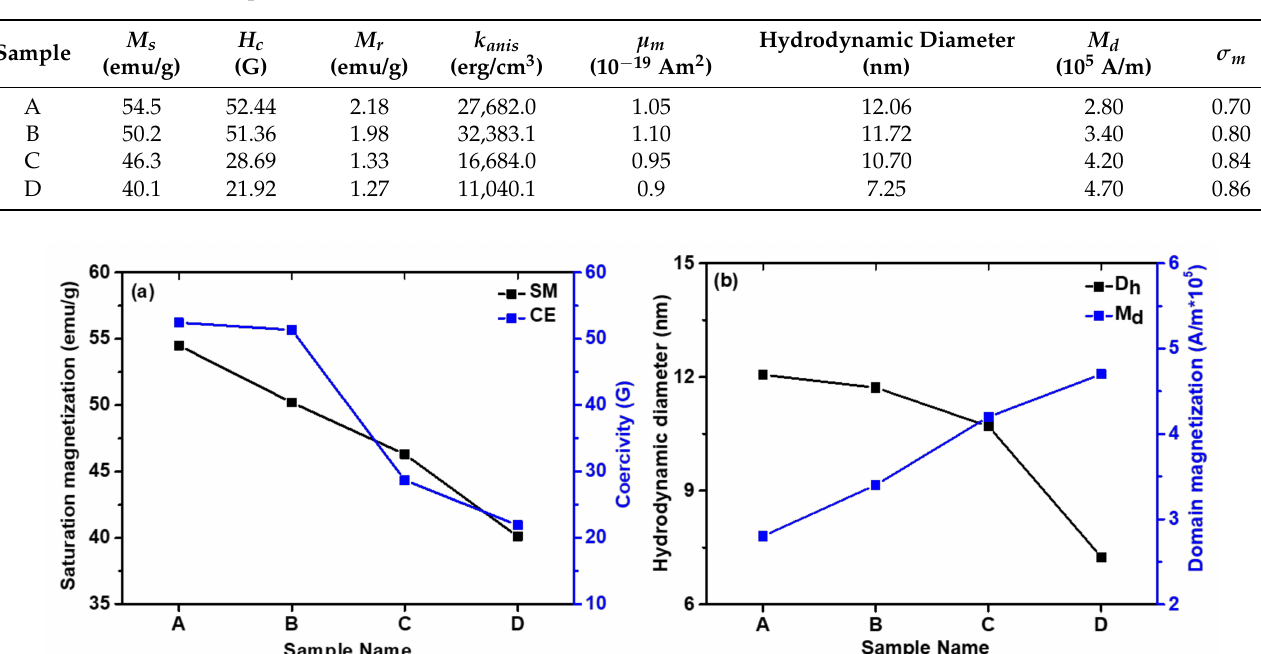
Figure 8. The room temperature M - H loop of the AMF samples with magnetic field in the range ± 2 T dc. The negligible coercivity in all the samples confirms the superparamagnetic nature of the samples. Table 3. The dc magnetic properties (saturation magnetization, coercivity, and remanence) and Langevin fitting parameters (domain magnetization ( M d ) and permeability ( µ m )), anisotropy constant, standard deviation ( σ m ), and hydrodynamic diameter of AMF samples.